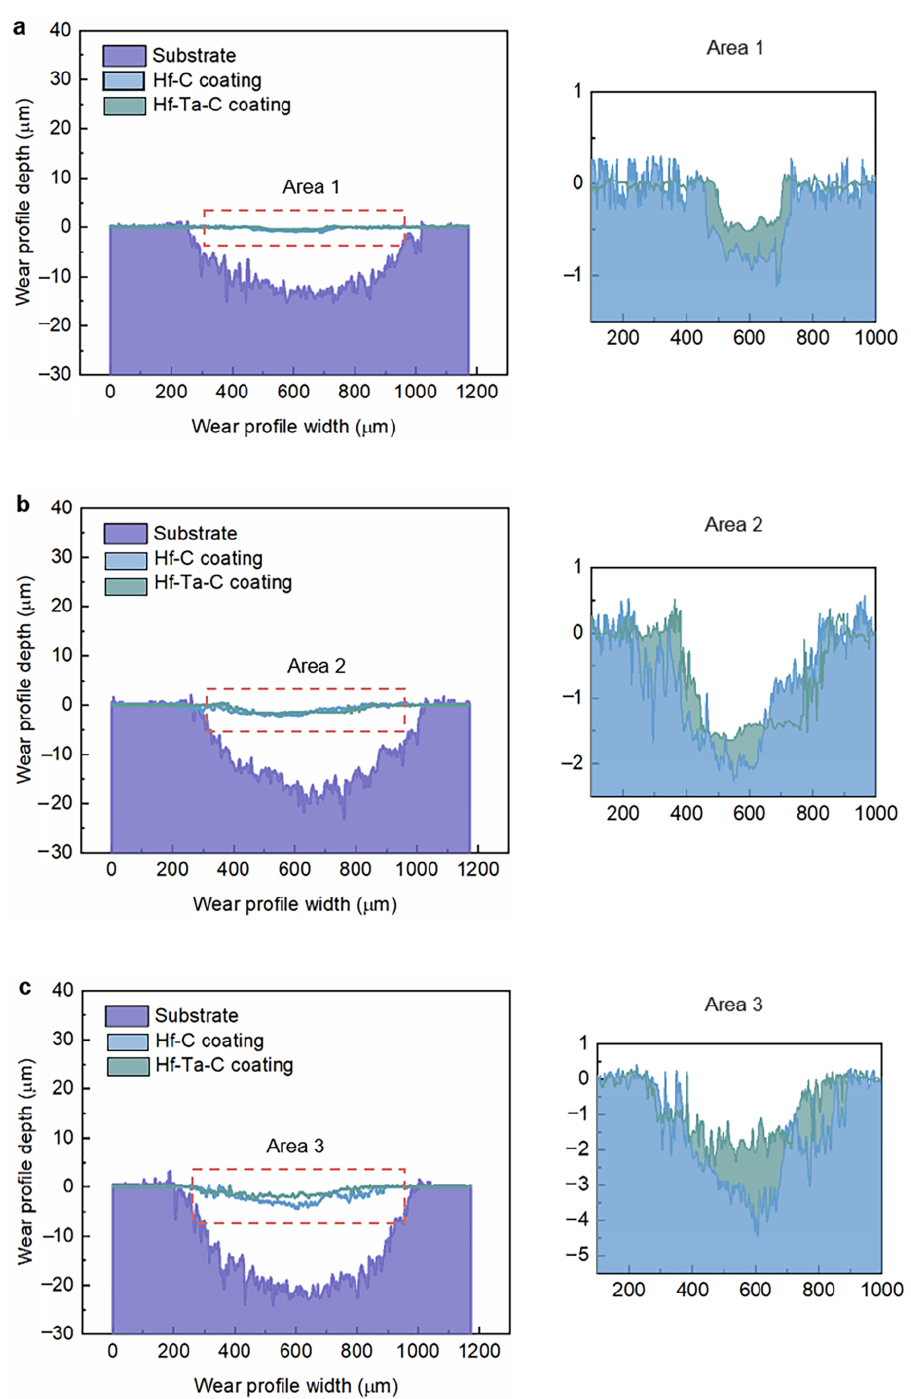
Figure 12. Wear profile under a load of ( a ) 2.2 N, ( b ) 4.2 N and ( c ) 6.2 N.